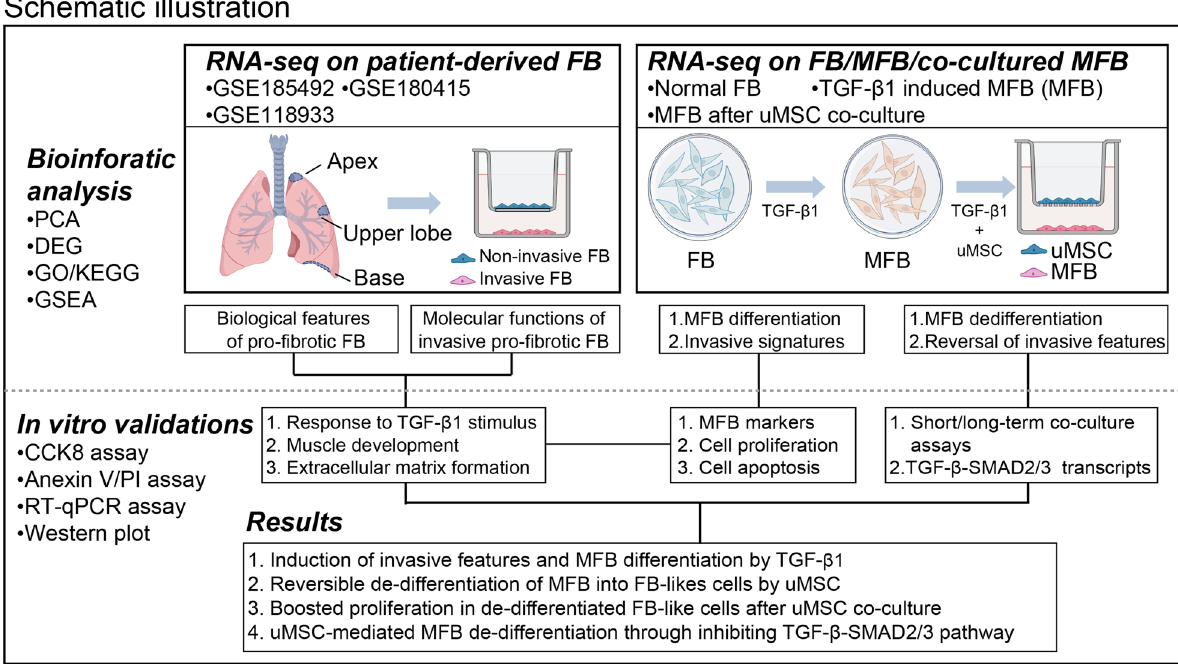
Fig. 1 Schematic illustration of the present study. PCA principal component analysis, DEG differential expressed gene, GO gene ontology analysis, KEGG Kyoto Encyclopedia of Genes and Genomes Atlas, GSEA gene set enrichment analysis, RNA-seq RNA sequencing, uMSC Umbilical cord-derived mesenchymal stem cells, TGF-β1 transforming growth factor-β1, FB fibroblast, MFB